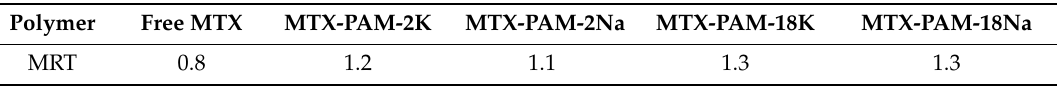
Table 1. Mean residence time (MRT) values of MTX released from polymer nanoparticulate systems at pH = 7.4.